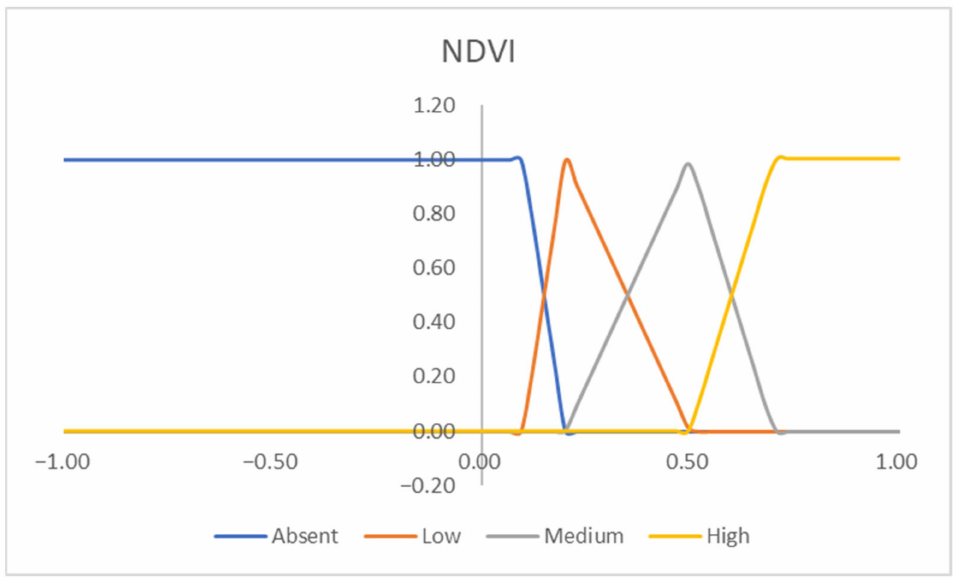
Figure 12. The initial fuzzy partition of the NDVI index given by 4 fuzzy